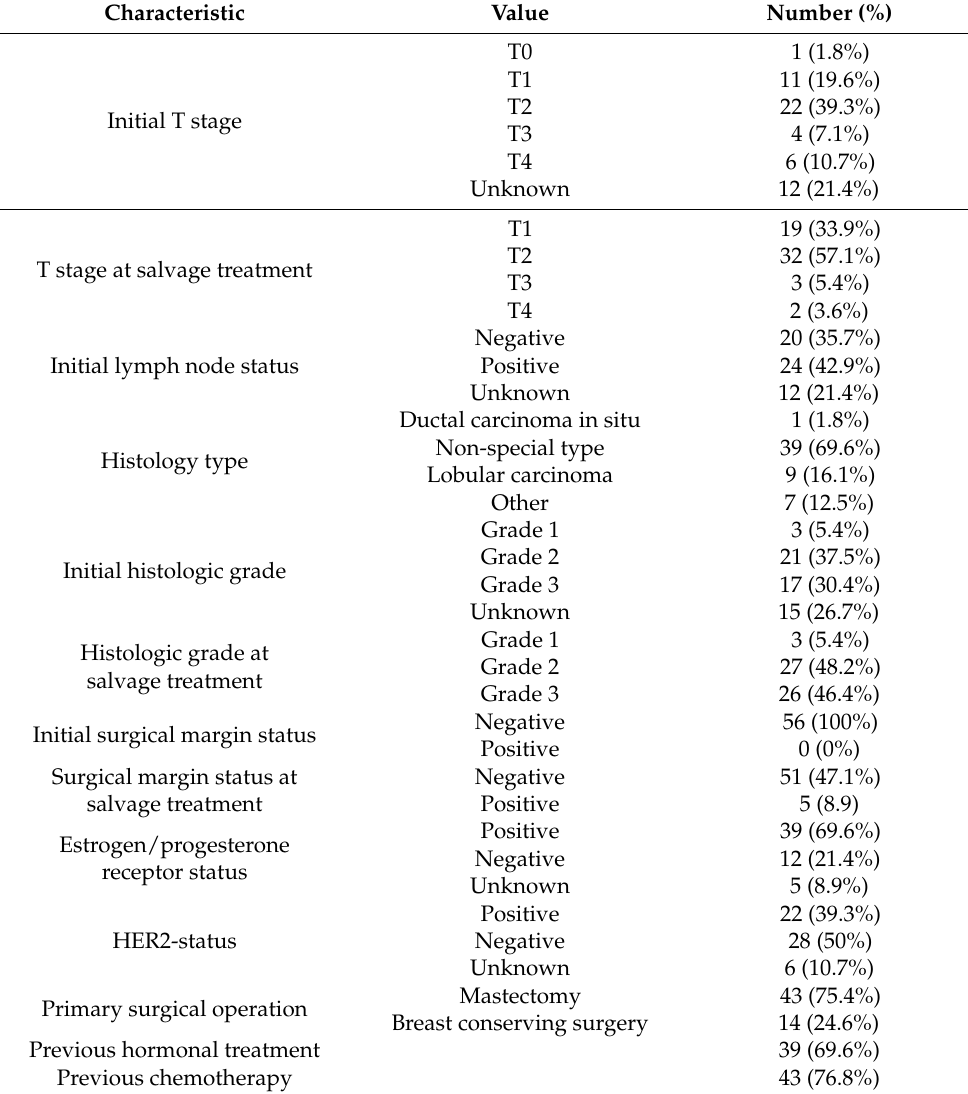
Table 1. Patients and disease